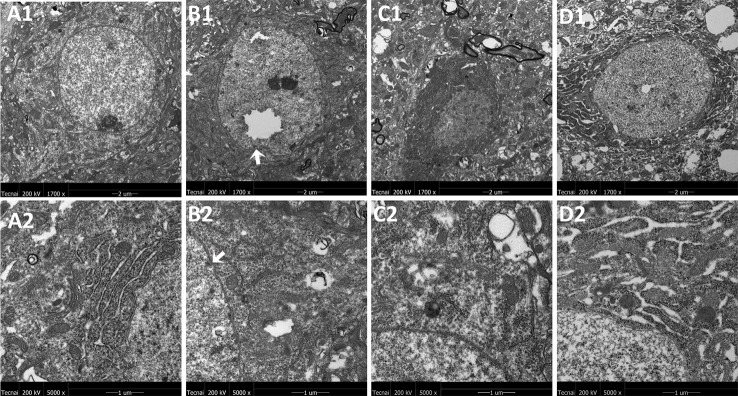
Mitochondria abnormalities identified in the frontal cortex region by transmission electron microscope. n = 3 for each group. Representative image of each group was viewed at 1,700 × (scale bar = 2 μm) and 5,000 × (scale bar = 1 μm) magnifications to detect changes in the frontal cortex mitochondria. A1: Representative image of low magnification (1,700×) image from control group. B1: Representative image of low magnification (1,700×) image from model group; The white arrow indicates mitochondria abnormalities. C1: Representative image of low magnification (1,700×) image from FLX group; D1: Representative image of low magnification (1,700×) image from JPZDD group; A2: Representative image of high magnification (5,000×) image from control group. B2: Representative image of high magnification (5,000×) image from model group; Abnormal mitochondrion is shown by the white arrow. C2: Representative image of high magnification (5,000×) image from FLX group; D2: Representative image of high magnification (5,000×) image from JPZDD group.